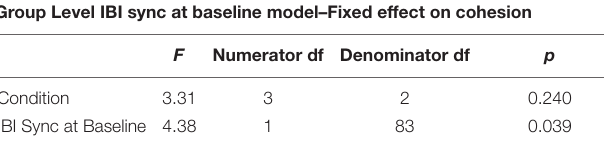
TABLE 5 | A mixed model predicting cohesion from IBI synchrony at baseline. Group Level IBI sync at baseline model–Fixed effect on